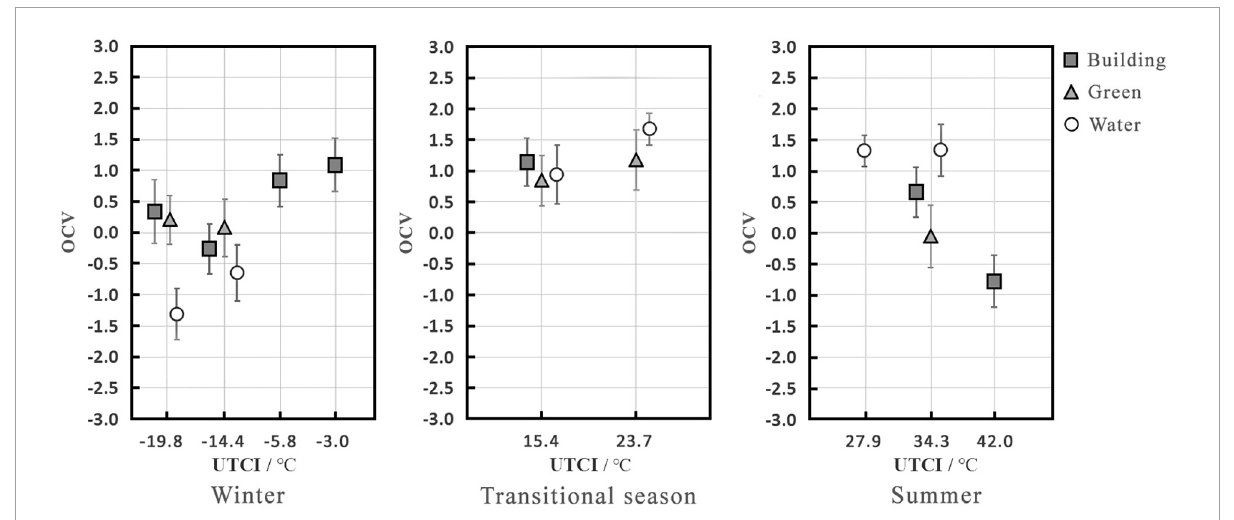
FIGURE5 Mean OCV under different thermal stress levels and between visual landscapes (abscissa is a categorical variable).